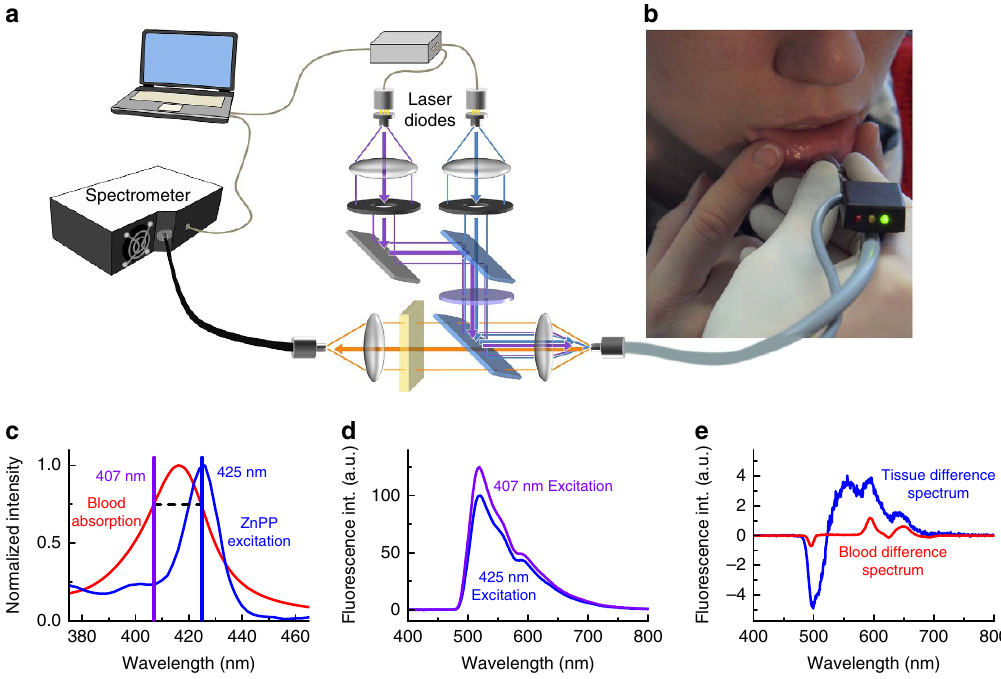
Figure 1 | Tissue fluorescence measurements using dual-wavelength excitation. ( a ) Simplified schematic of the set-up. Light of two laser diodes at 407 and 425nm is superimposed and coupled into an optical fibre for fluorescence excitation. The generated fluorescence is collected by the same fibre and detected with a spectrometer. ( b ) Photograph of the measurement procedure with the fibre-optic probe placed on the lower lip. An adequate blood absorption index is indicated by the green light on the black indicator box. ( c ) The fluorescence excitation maximum of red blood cell zinc protoporphyrin (ZnPP) is at 425nm. The second excitation wavelength of 407nm is chosen for identical blood absorption. ( d ) Typical fluorescence spectra of the oral mucosa of a single subject with elevated ZnPP/haem ratio when excited with 425 and 407nm. ( e ) Difference spectrum of the spectra in d with normalized 407-nm spectrum, resulting in background reduction of B 93%. The corresponding difference spectrum of a measurement in whole blood using the same instrumentation in vitro is shown in red, obtained by placing the optical fibre in a sample of whole